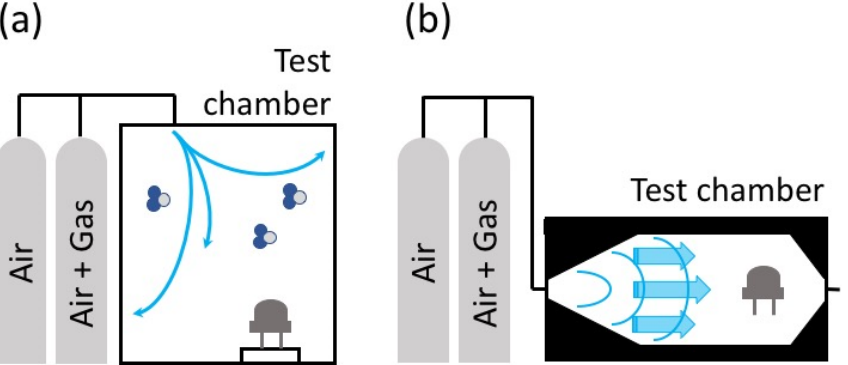
Figure 1. Schematic representation of diffusion and flow phenomena occurring in test chambers. ( a ) flow through pipelines and diffusion inside the test chamber volume; ( b ) flow through pipelines and the test chamber volume.